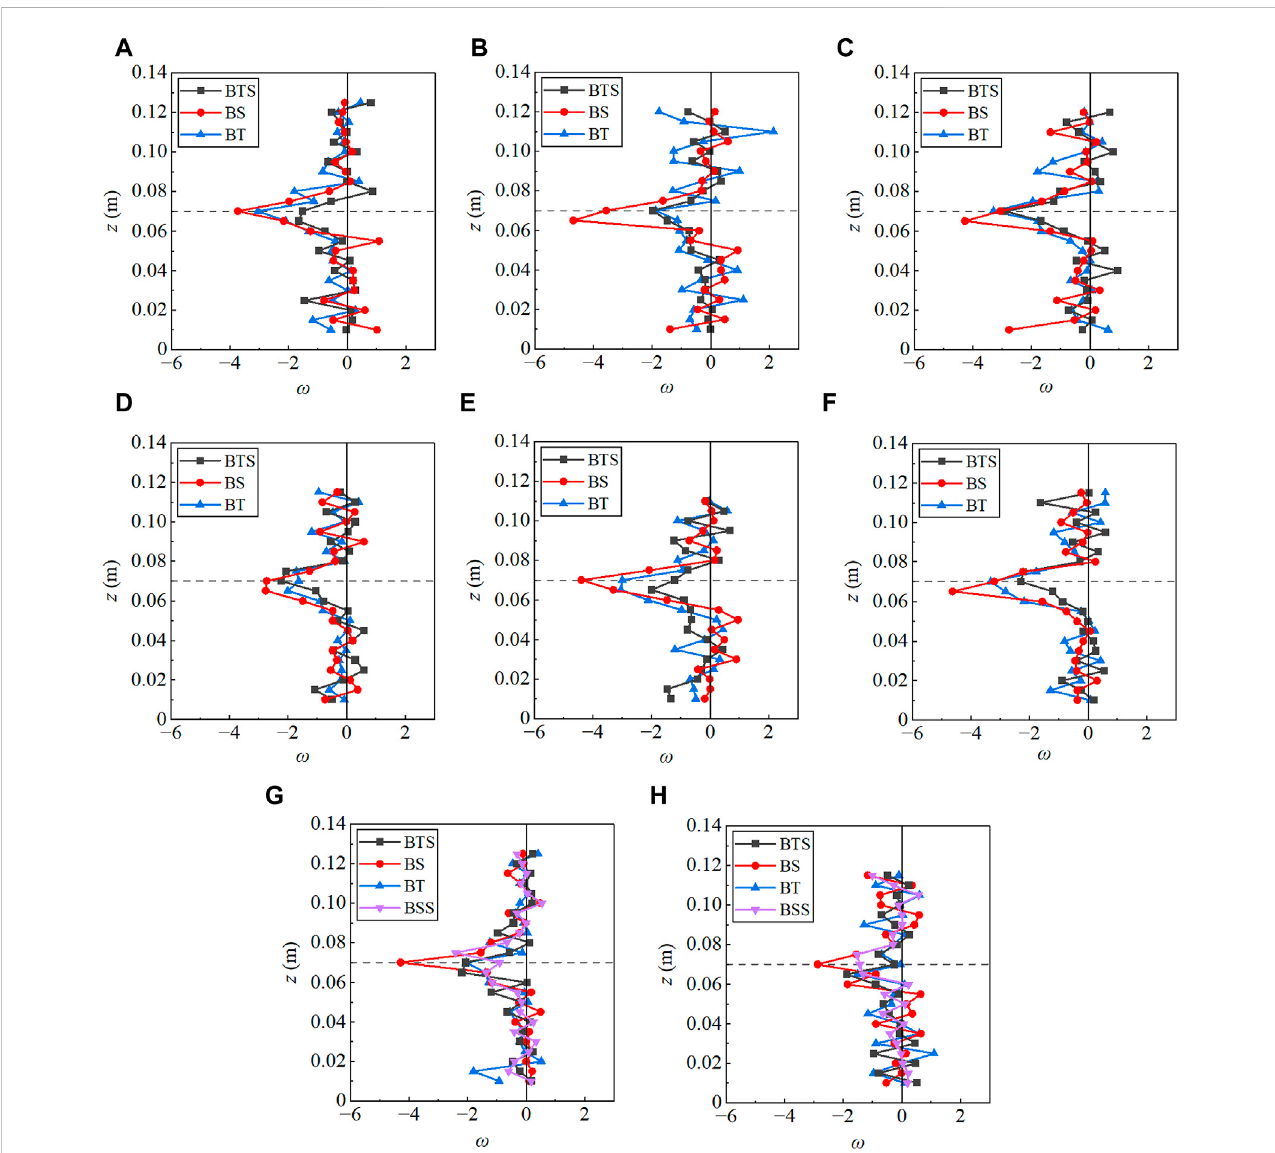
FIGURE 6 Lateralvorticitypro fi leofdifferentmeasurementlocations, (A – C) presentresultsforrunsXHS1toXHS3, (D – F) presentresultsforrunsXLS1toXLS3, (G,H) present results for runs YHS1 and YLS1, respectively. The black dotted line represents the height of the short